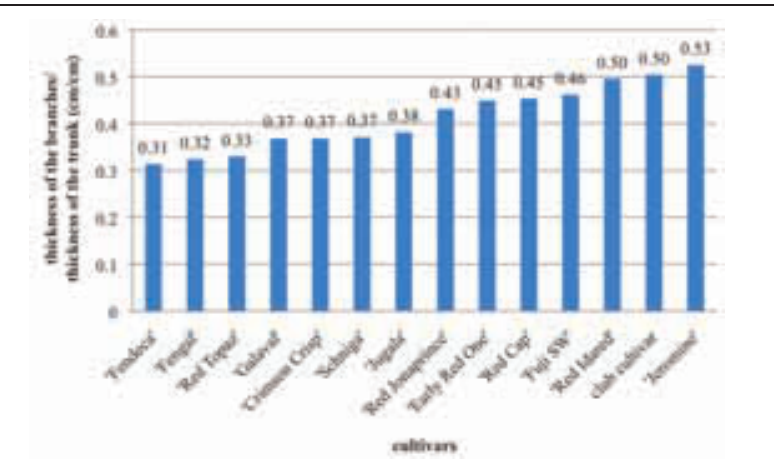
Figure 2: The Zahn-index of the main branches of apple cultivars (Nyírbátor,